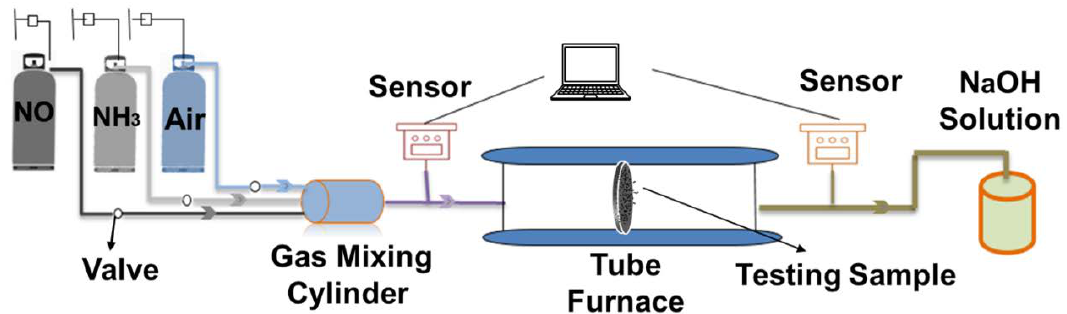
Figure 2. Schematic illustration of our home-made ammonia selective catalytic reduction (NH 3 -SCR) denitration testing